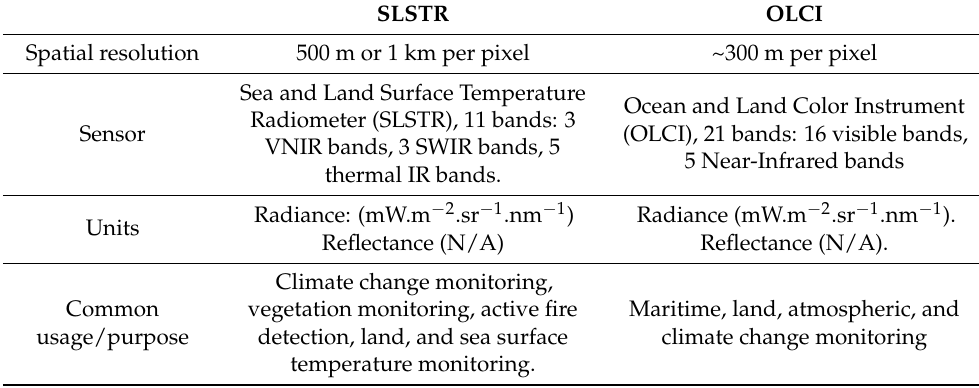
Table 1. Main characteristics of the SLSTR and OLCI instruments onboard Sentinel-3 [4].